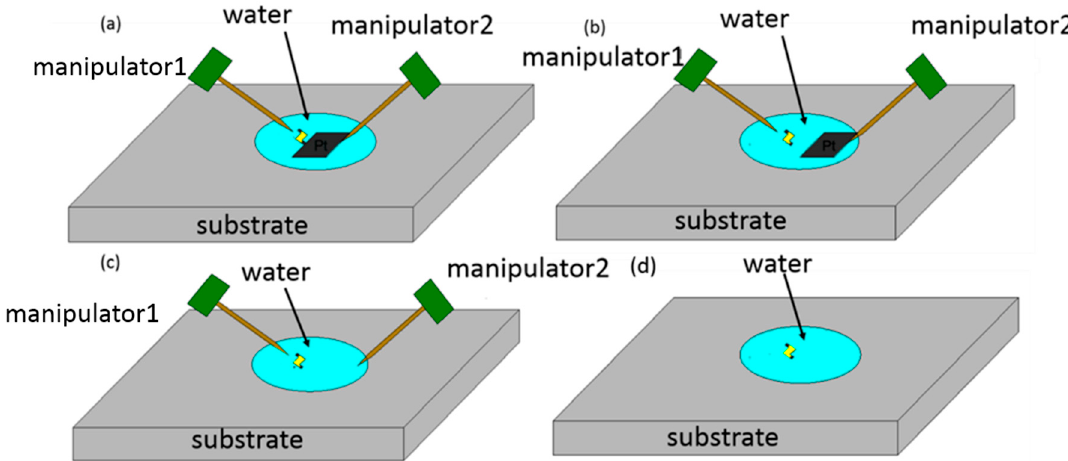
Figure 4. Schematic of manipulation method. ( a ) Cutting off the Z-shaped Pt/Au hybrid nanorobot from the Pt probe. ( b ) Removing the Pt probe stage. ( c ) Releasing the nanorobot into water with a chopsticks-like manipulator [16–20]. ( d ) Injection of hydrogen peroxide solution.